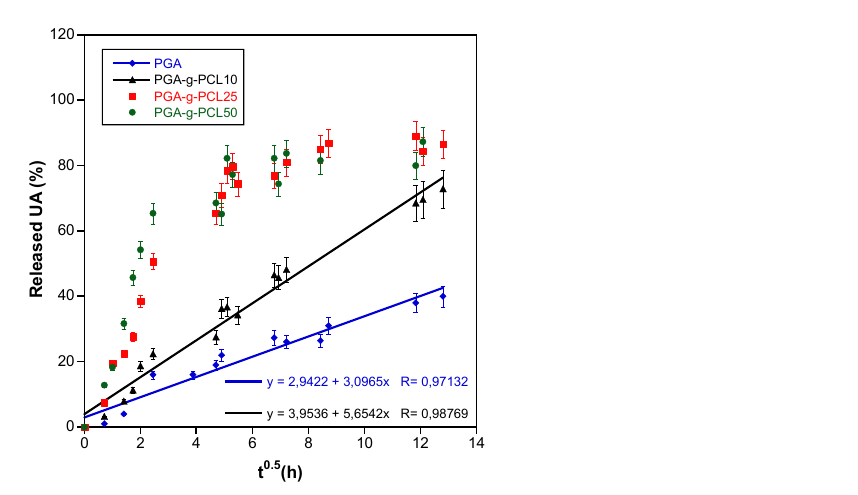
8 of 15 Table 3. Korsemeyer–Peppas transport exponent ( n ) and correlation coefficient (R) for the UA ‐ loaded nanoparticles. Polymer